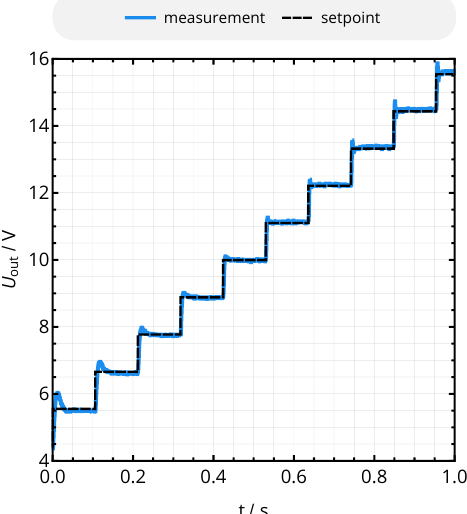
Figure 13. Series of step responses of the voltage control loop for d 12 = 20mm ( M 12 = 14nH) and P out = 25mW. Overshoots and rise time change with U out , as the latter determines the effective load resistance R L,2 and, therefore, the characteristics of the transfer